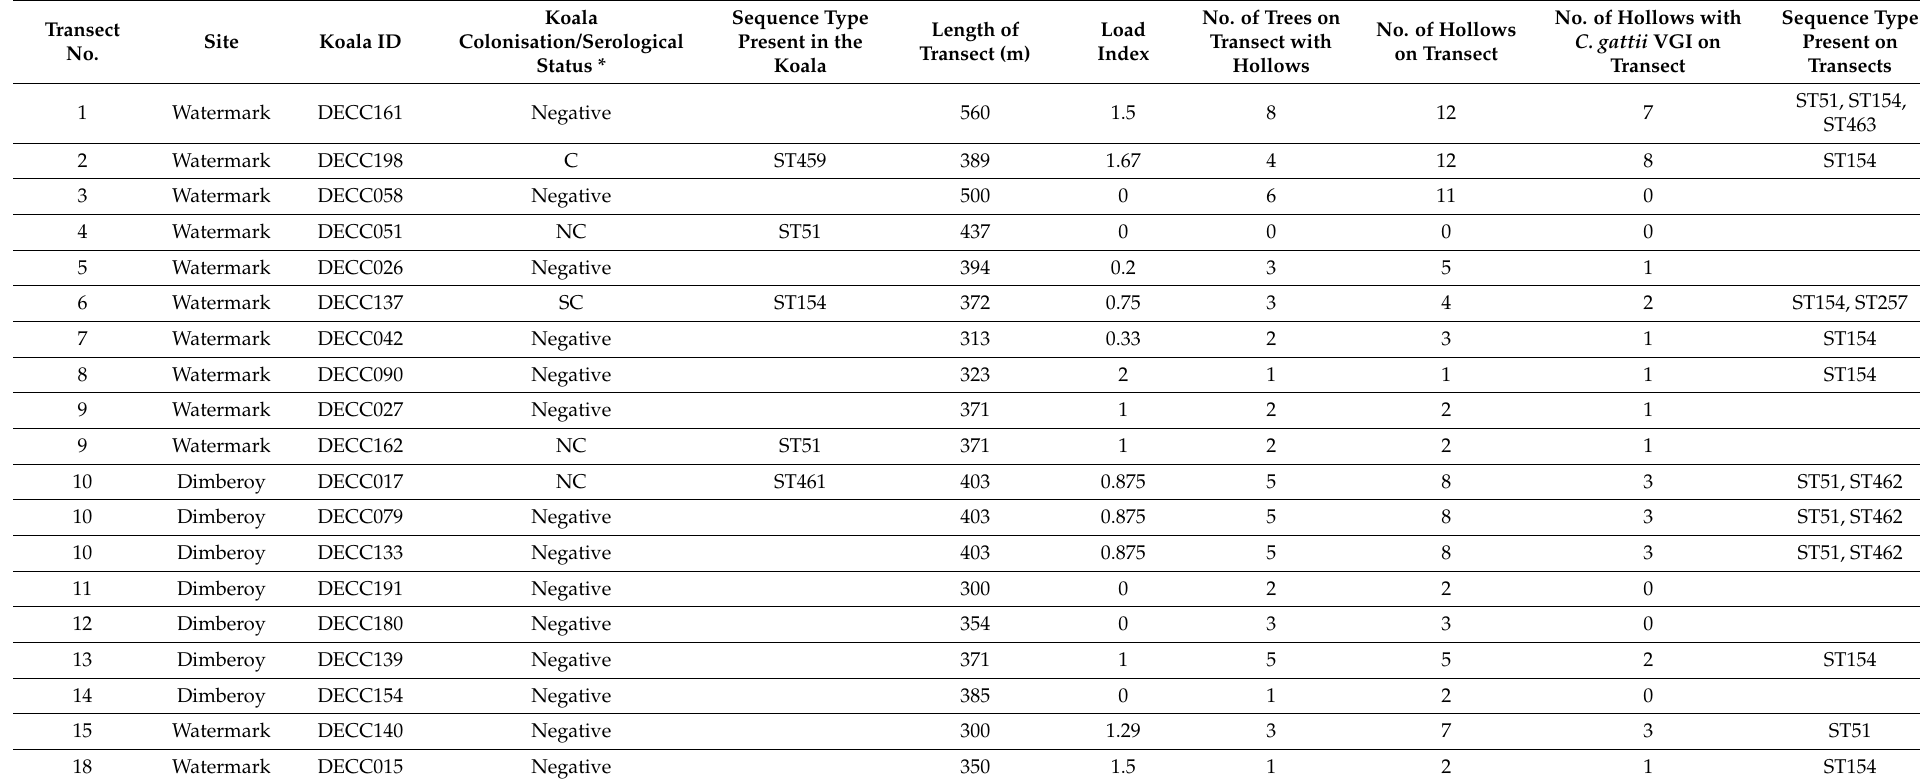
Table 1. Transects correlated with koalas with known home ranges overlapping the